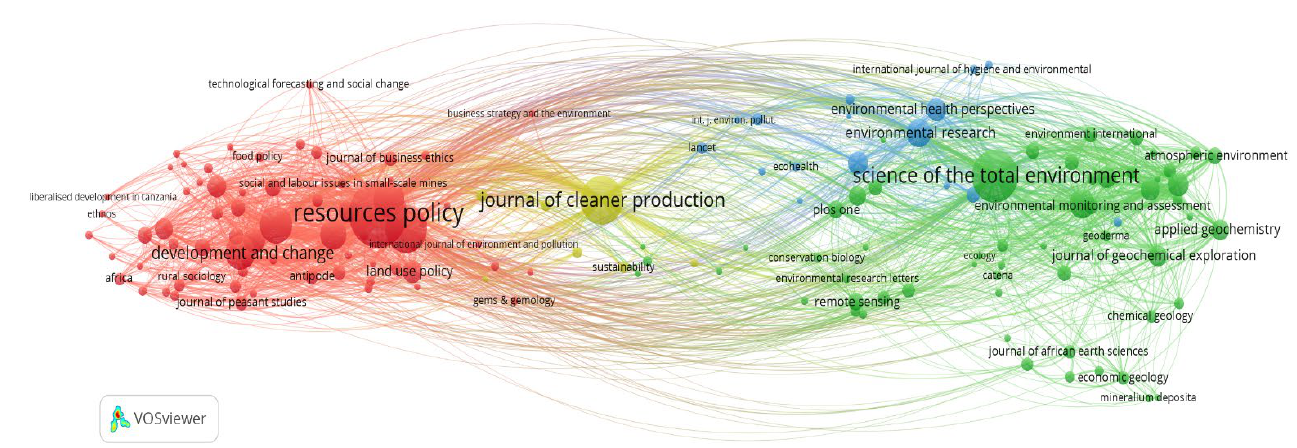
Figure 8. Journal co-citation network in ASM.